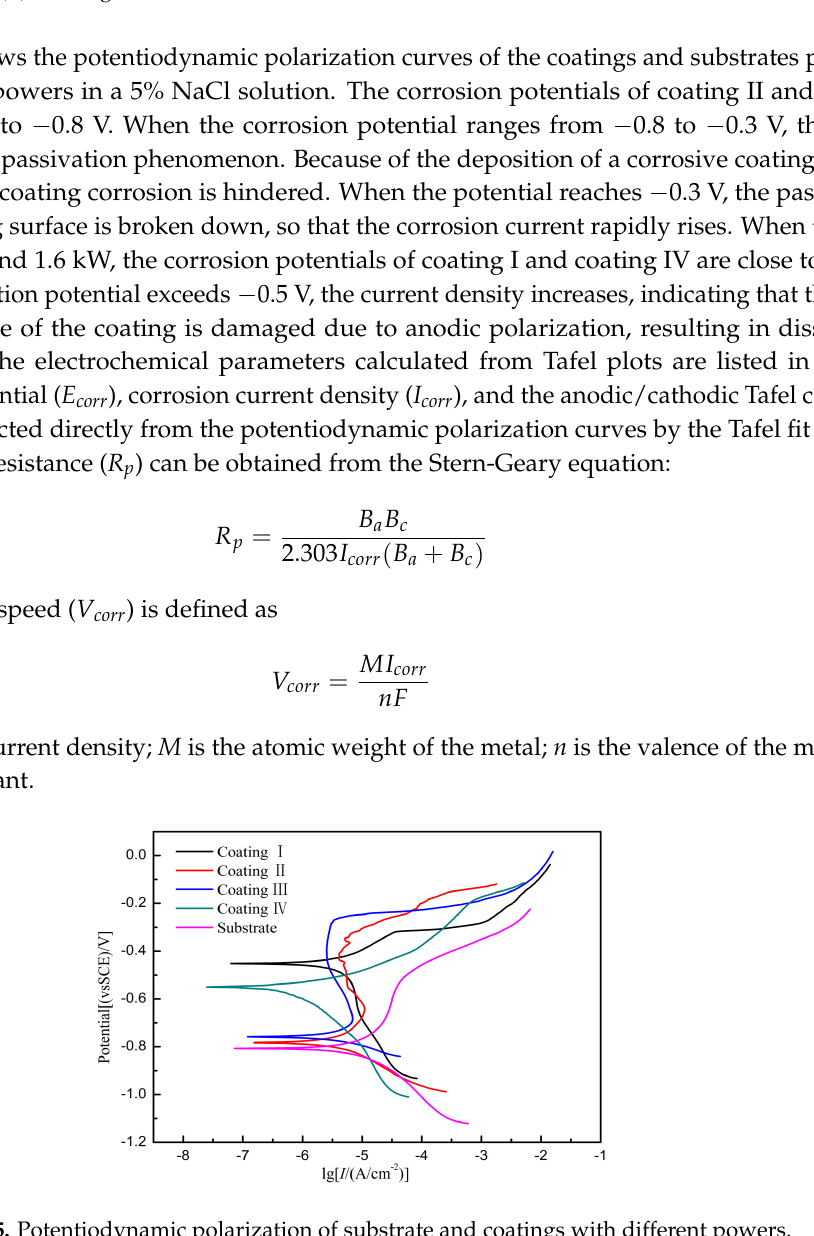
Figure 14. The surface low magnification morphology of the coating: ( a ) Coating I; ( b ) Coating II; ( c ) Coating III; ( d ) Coating IV.